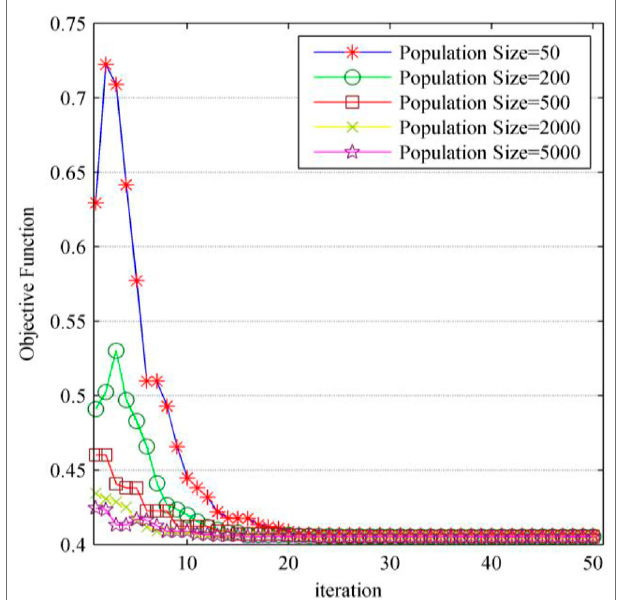
FIGURE 11 | Comparison of consequence speeds with different population size in IEEE 33-bus system. FIGURE 12 | Comparison of consequence speeds with different